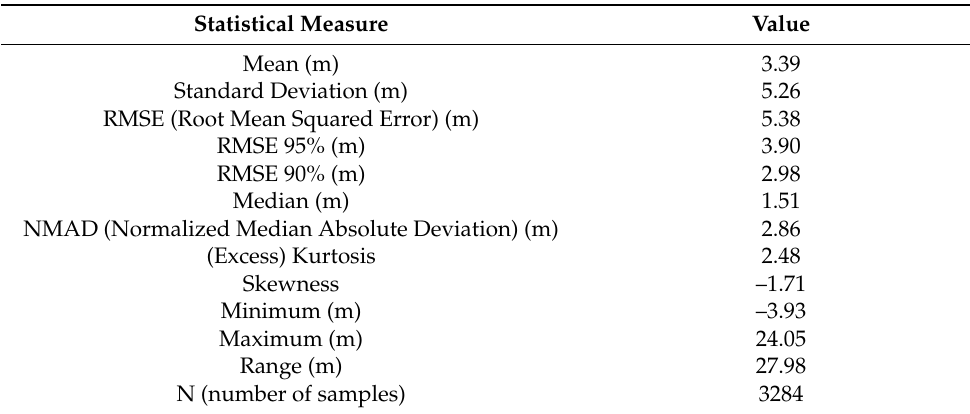
Figure 9. Histogram and cumulative distribution of ( h DTM − h SONAR ) values. Table 2. Descriptive and other statistics of the bathymetric model errors ( h DTM − h SONAR ).